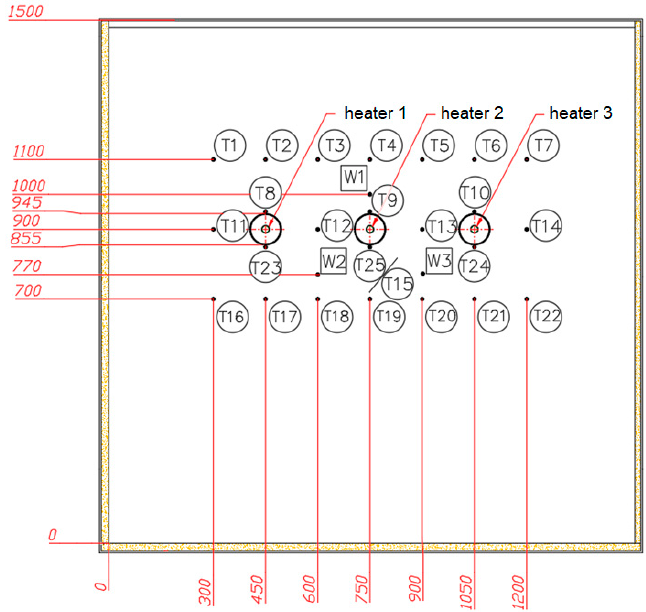
Figure 6. The location of thermocouples at the experimental stand.